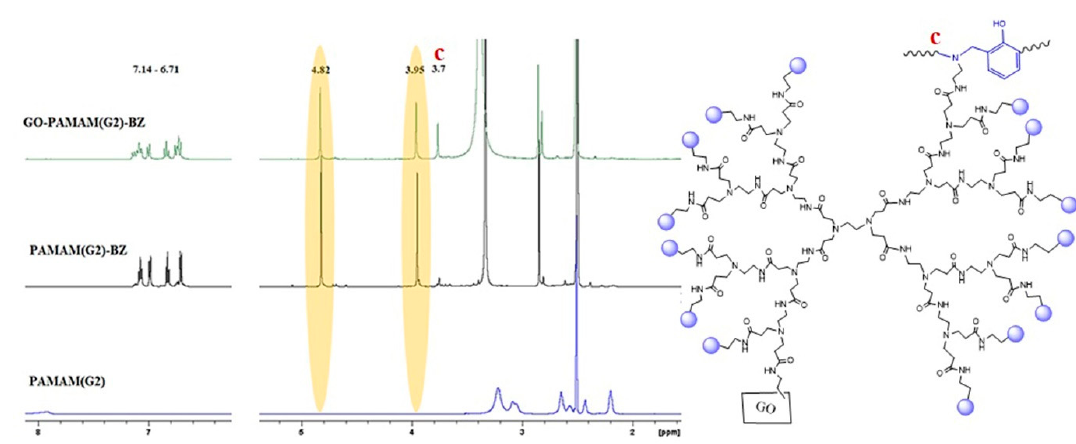
Figure 6. 1 H-NMR spectra for PAMAM(G0), PAMAM(G0)-BZ and GO-PAMAM(G0)-BZ .